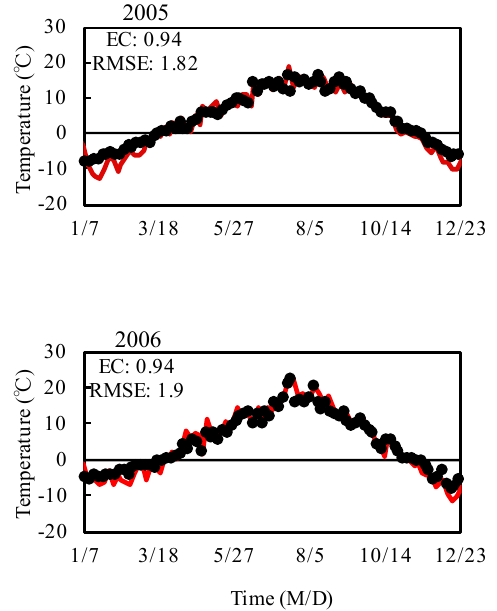
Figure 4. Comparison between simulated (red solid line) and mea- sured (black dashed line) results for soil temperature at 15cm depth Figure 4: Comparison between simulated (red solid line) and measured (black dashed line) results for soil in 2005–2006. temperature at15 cm depth in 2005-2006.